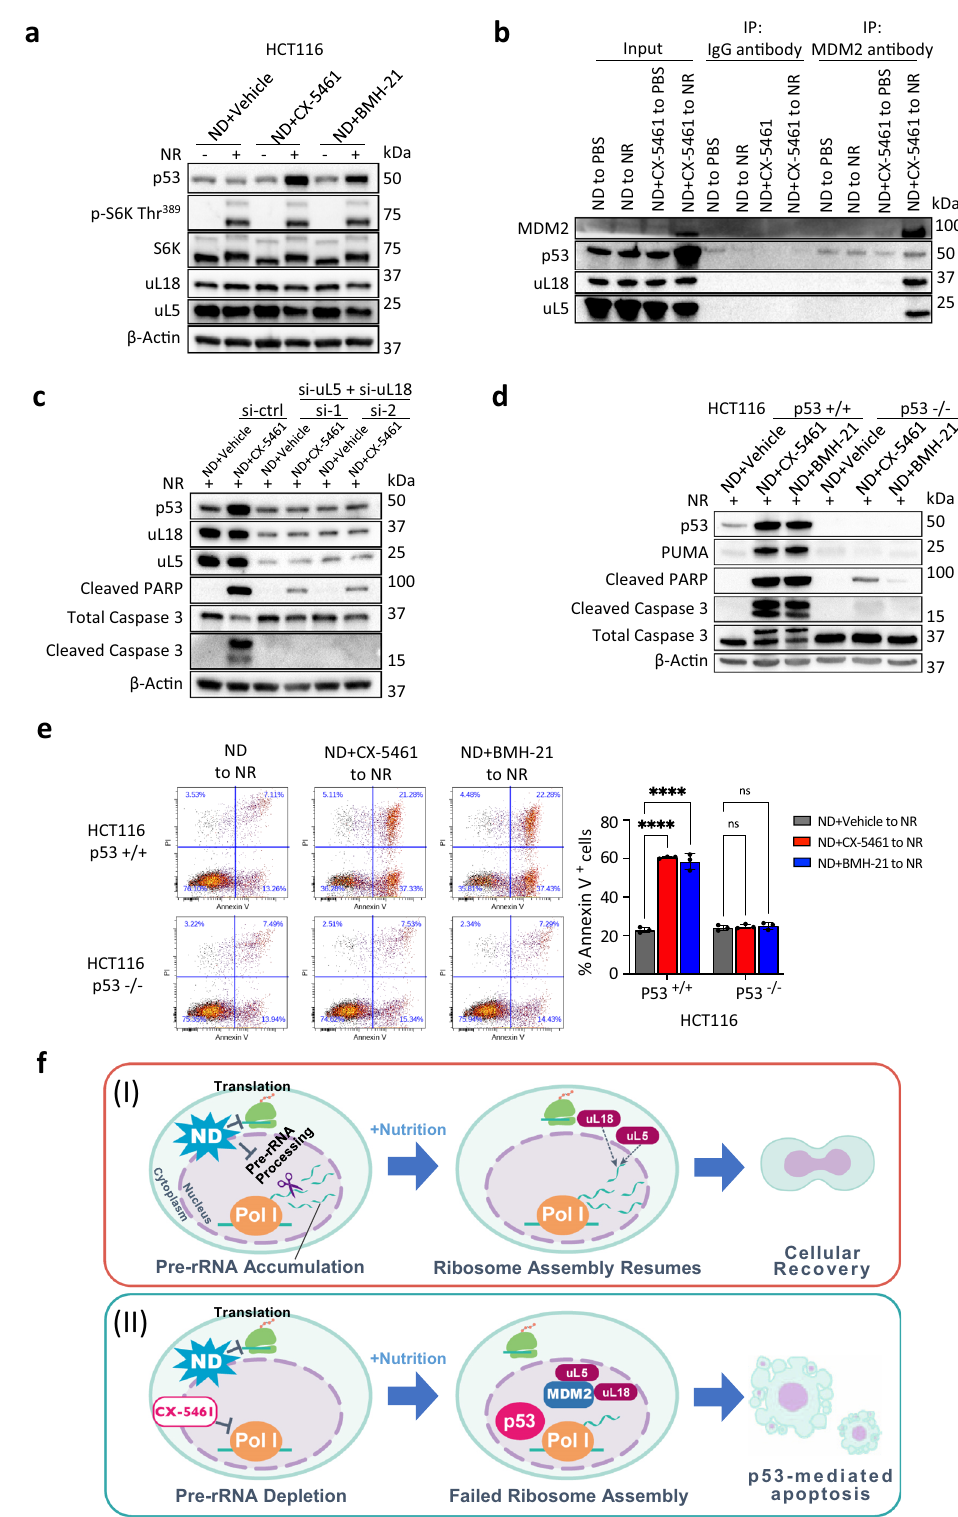
deprivation blocked the activation of p53 by 1 μ M CX-5461, while the withdrawal of glucose or other amino acids had no effect (Fig. 6a, Supplementary Fig. 6a). Glutamine deprivation did not inhibit p53 stabilization by the MDM2 inhibitor AMG 232 (Supplementary Fig. 6b). Suppression of p53 transcriptional activity under glutamine deprivation was con fi rmed by measuring p21 mRNA (Supplementary Fig. 6c). The inhibition of p53 was